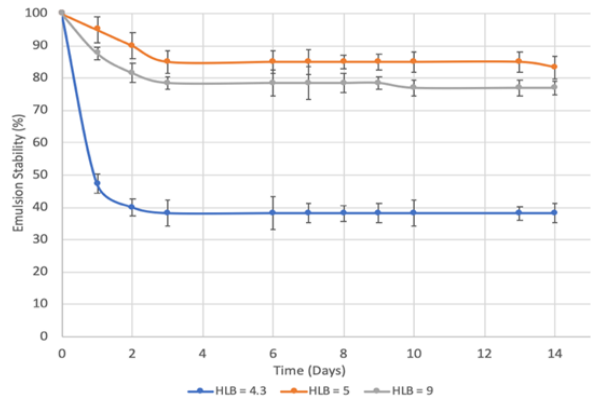
Figure 8. Emulsion stability vs. time: effects of changing the surfactant HLB.